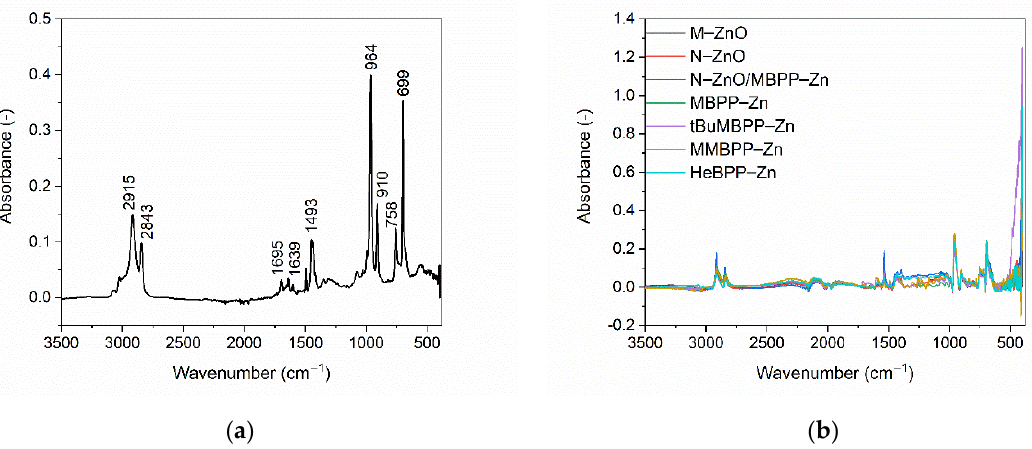
Figure 7. Fourier Transform Infrared (FTIR) spectra of: ( a ) pure SBR rubber; ( b ) SBR vulcanizates containing ZnO and zinc complexes with 1,3-diketones as activators.